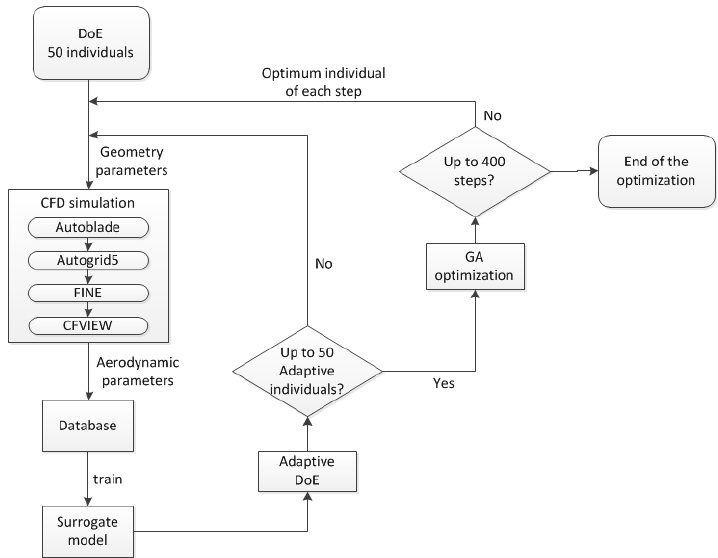
Figure 13. Scheme of the MINAMO optimization integrated in the Design3d module.